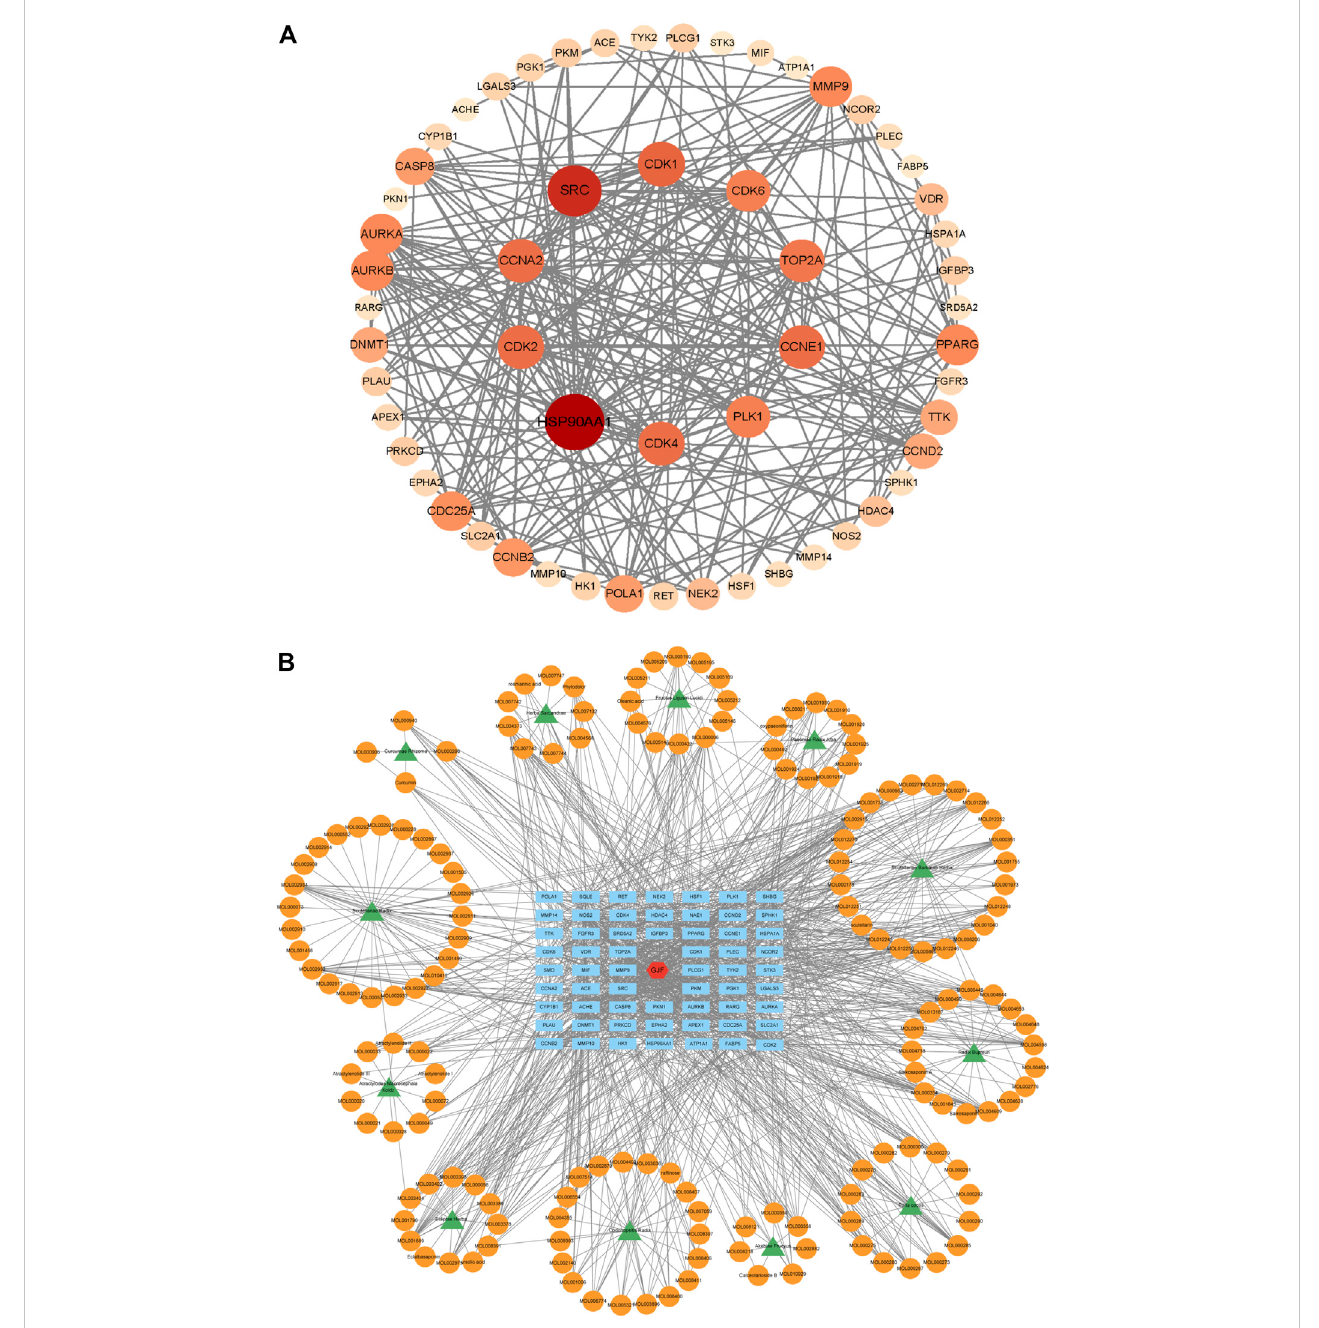
targets with the highest connection degree) (B) Herb-compound-target network of GJF (green represents the name of traditional Chinese medicine, orange represents the active ingredient, blue represents the key gene target, and red represents Ganji